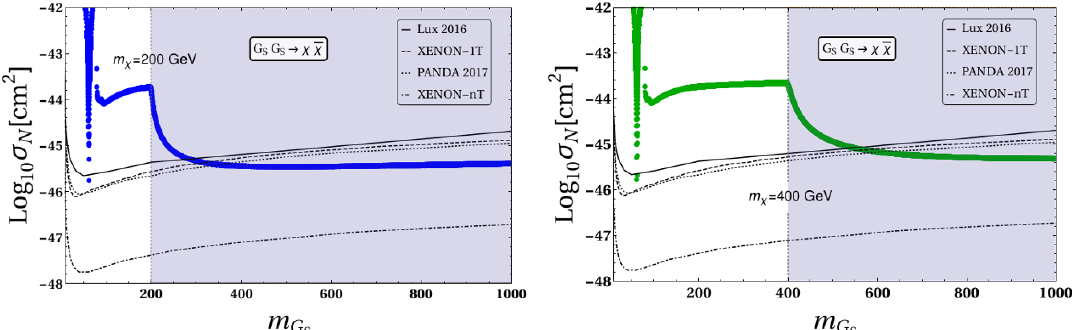
(in GeV) space allowed by the relic density constraint. We S = 200 GeV (left) or m (cid:31) = 400 GeV (right). 0 0